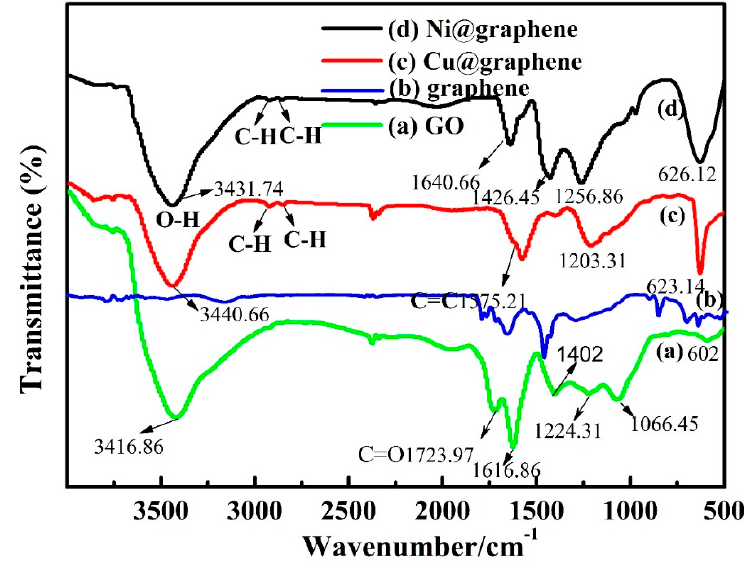
Figure 7. The Fourier transform-Infrared (FT-IR) spectra of ( a ) GO; ( b ) graphene; ( c ) Cu@graphene and ( d ) Ni@graphene.